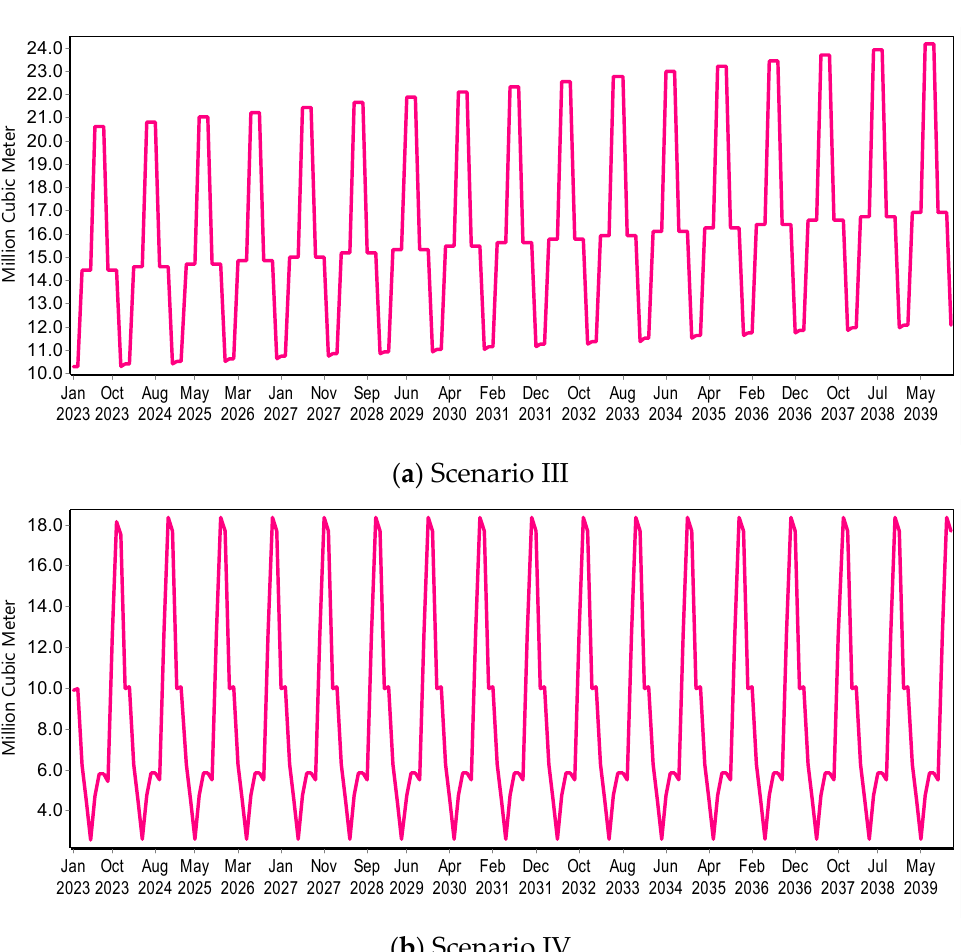
Figure 13. Public water supply abstractions for PWS 1 in scenarios III and IV (million cubic meter per month).